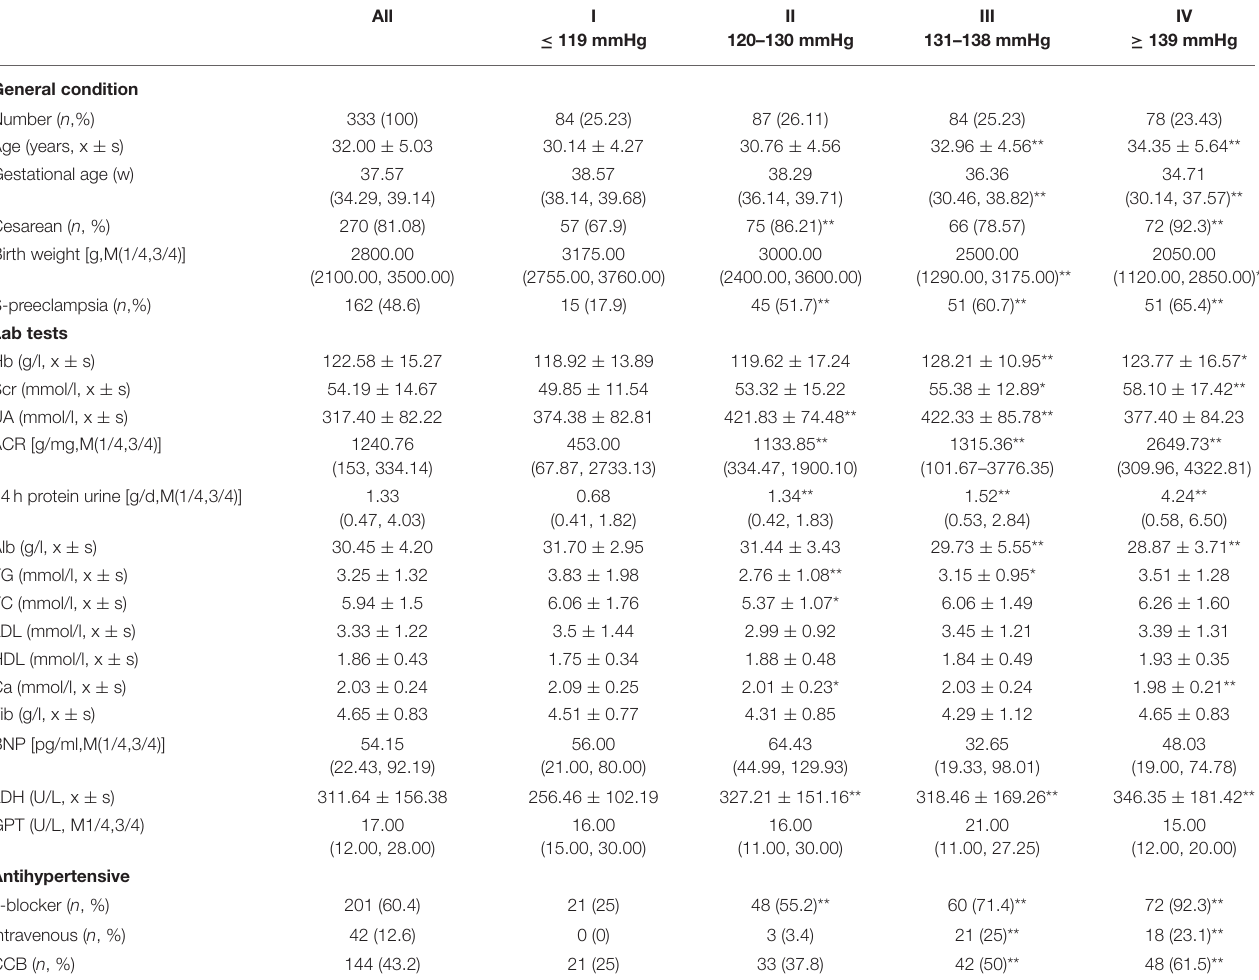
TABLE 1 | Basic patient demographic characteristics and laboratory data by quartiles of prenatal first systolic blood pressure (SBP) in patients with preeclampsia.